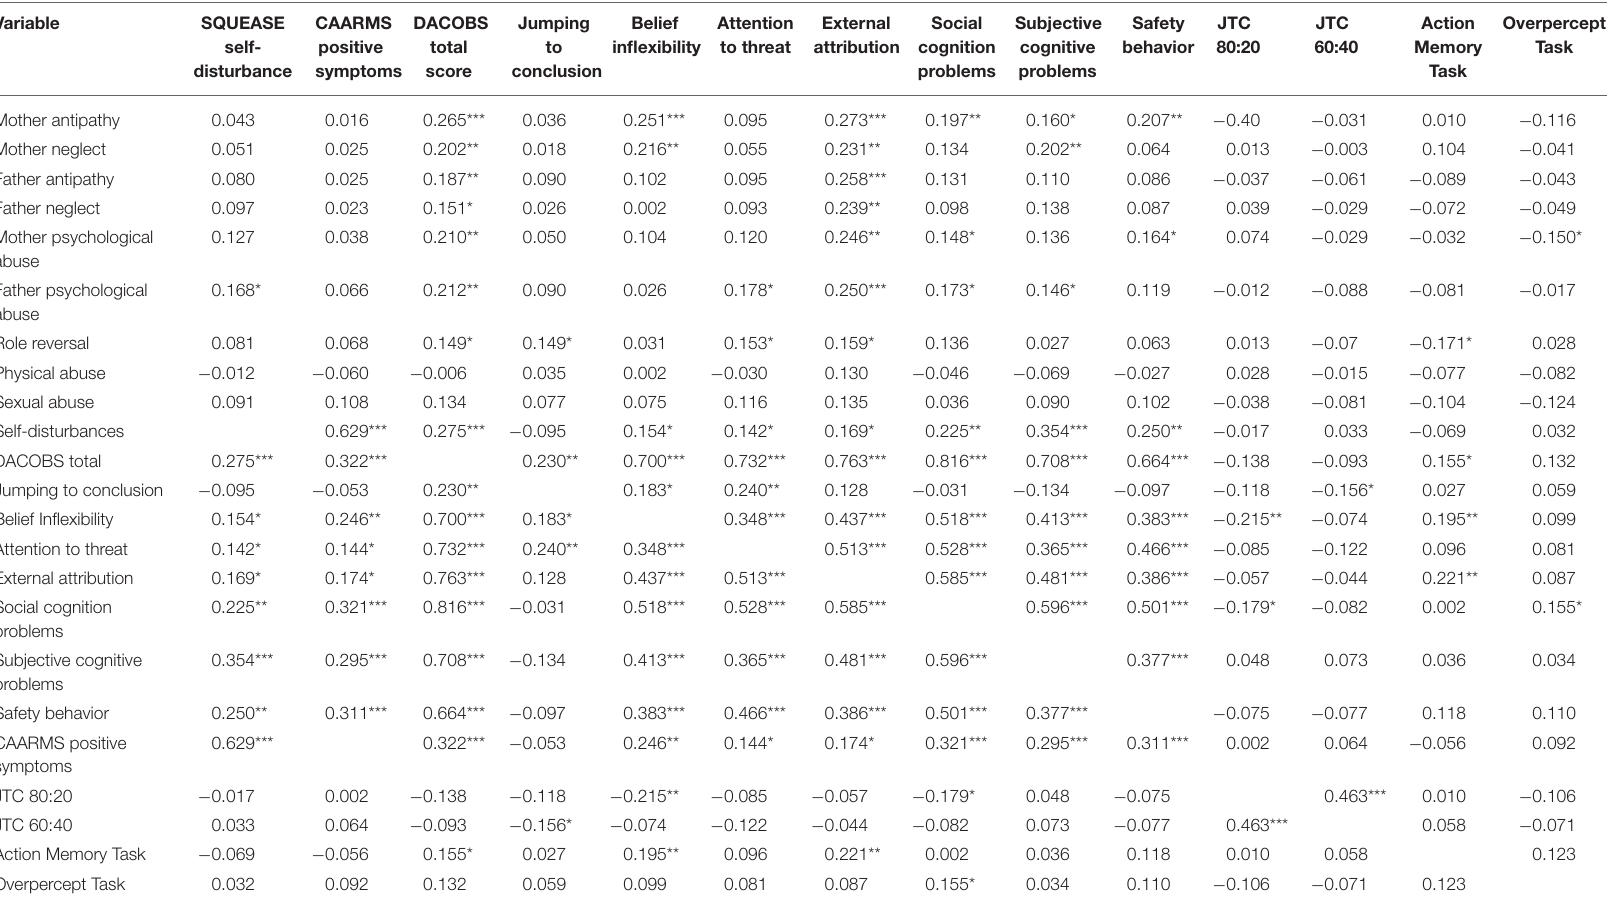
TABLE 2 | Correlational